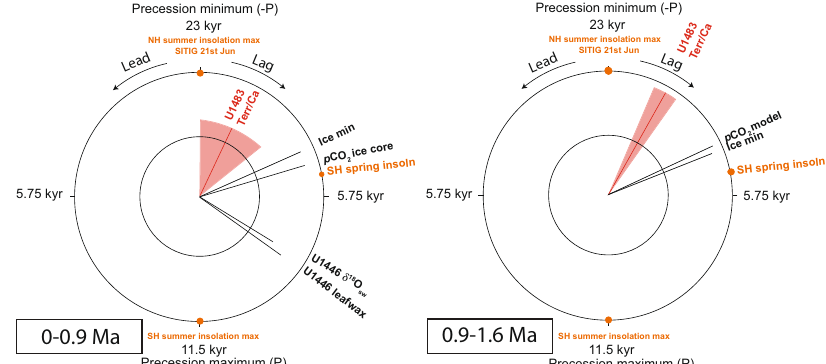
Fig. 5 | Phase wheel summaries of cross-spectral coherence and phase rela- tionshipsattheprecessionbandfrom0to0.9Maandfrom0.9to1.6Ma. Zero phase is set to 21st June perihelion. Clockwise phases represent lags, and coun- terclockwise phases represent leads. Inner circle denotes coherency levels of k>0.48 (con fi dence interval >90%) at 0.00556 bandwidth. The length of each vector corresponds to coherency (0 at center, 1 at circumference). Shaded areas